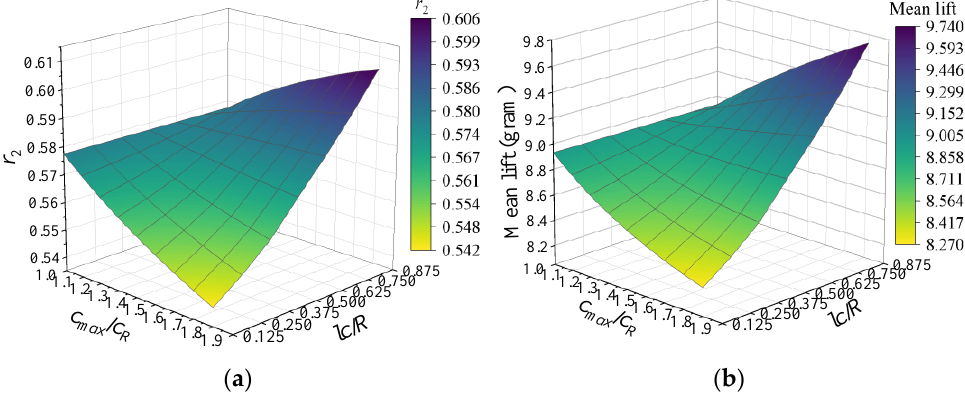
Figure 11. ( a ) The dimensionless radius of the second moment of area r 2 and ( b ) lift performance with respect to the magnitude and location of the maximum chord length c max at the flapping frequency of 16 Hz.